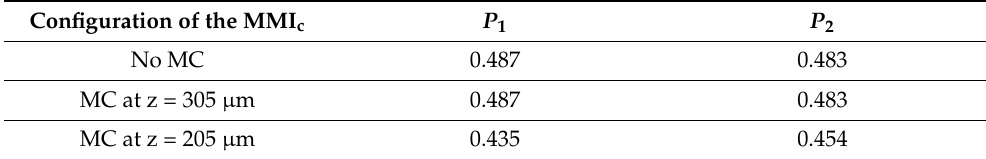
Table 1. Transmitted power from the MMI c in all the explored cases.